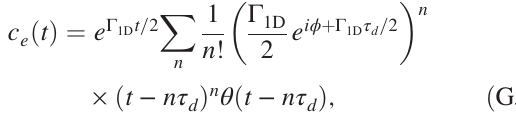
FIG. 11. Replots of the five (white) line cuts in Fig. 4(c), with accompanying theoretical predictions for emission of a qubit into a dispersionless, lossless semi-infinite waveguide. In the theoretical model, τ is maintained fixed for all simulations, while d the qubit emission rate Γ 1 and round-trip phase ϕ are allowed D to vary as fit parameters to capture the effects of the changing flux-modulation amplitude, which not only changes Γ 1 but also D causes a residual dc shift of the average qubit frequency [77], which, in turn, affects ϕ . Moreover, a thermal qubit population of 2.4% is assumed. From top to bottom, the fit parameters Γ 1 D = 2 π ¼ 0 . 17 MHz, ϕ ¼ π = 2 . 6 ; and ϕ are, respectively, Γ 1 D Γ 2 π ¼ 0 . 6 MHz, ϕ ¼ π = 2 . 6 ; Γ 2 π ¼ 1 . 8 MHz, ϕ ¼ 1 D = 1 D = π = 2 . 1 ; Γ 2 π ¼ 5 MHz, ϕ ¼ π = 2 . 6 . Note that the parameter 1 D = ϕ small Γ 1 , ϕ simply modulates the emission rate. However, for D of the population dynamics curves are sensitive to ϕ